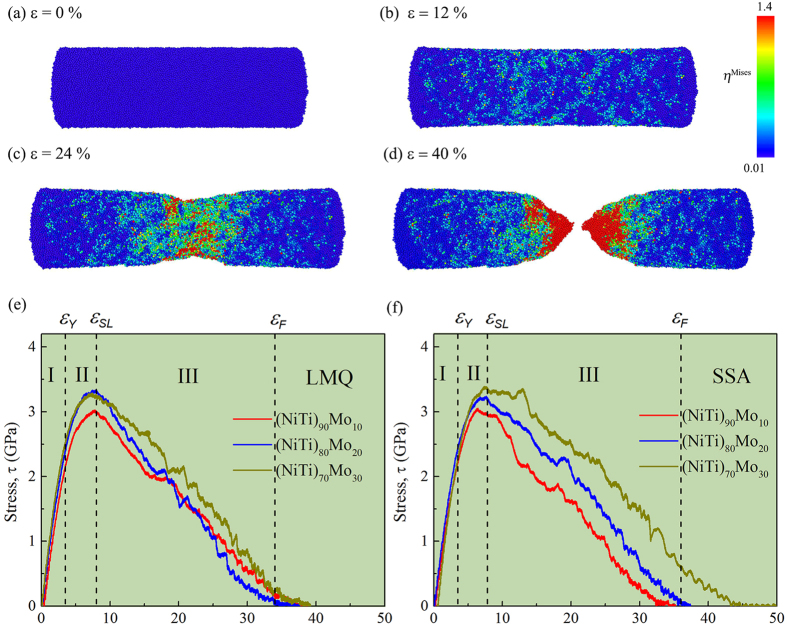
Schematic diagram at different strains (a–d) of the (NiTi)80Mo20 MGs obtained by LMQ containing ~155000 atoms at 100 K. Simulated stress-strain curves under uniaxial tensile loading for (NiTi)90Mo10, (NiTi)80Mo20, and (NiTi)70Mo30 MGs containing ~155000 atoms at 100 K obtained by LMQ (e) and SSA (f).